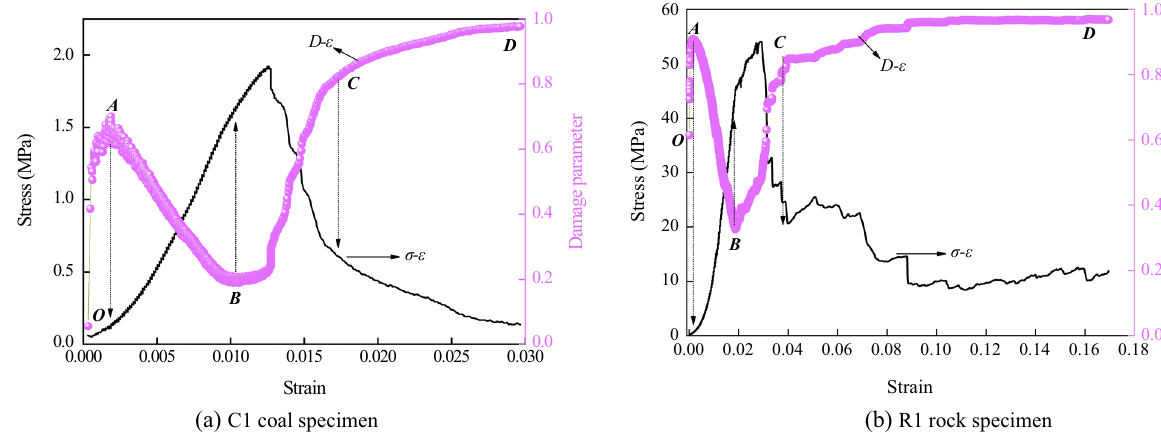
Fig. 9 Damage parameter evolution of coal and rock specimens under uniaxial loading